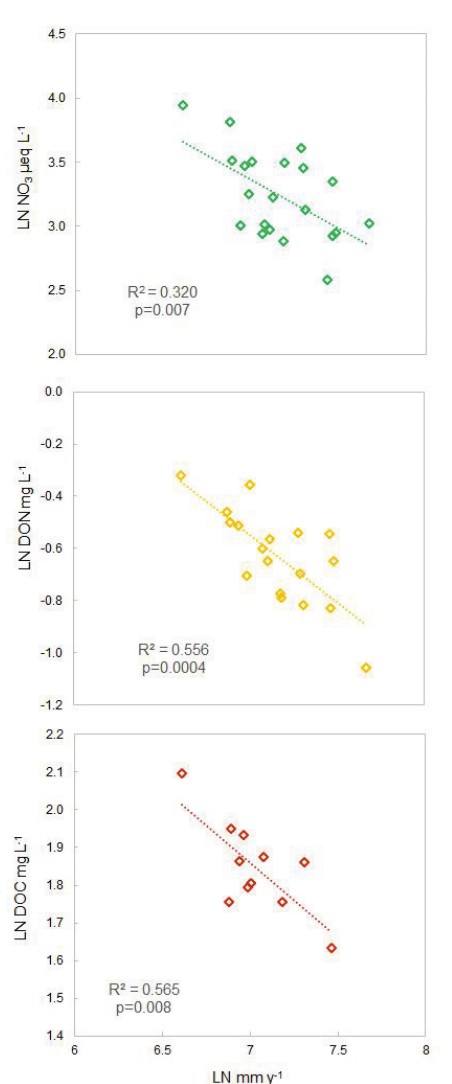
Figure 3. Relationship between the amount of precipitation (mm yr -1 ) and the concentrations of NO DON and DOC in the throughfall (mg L -1